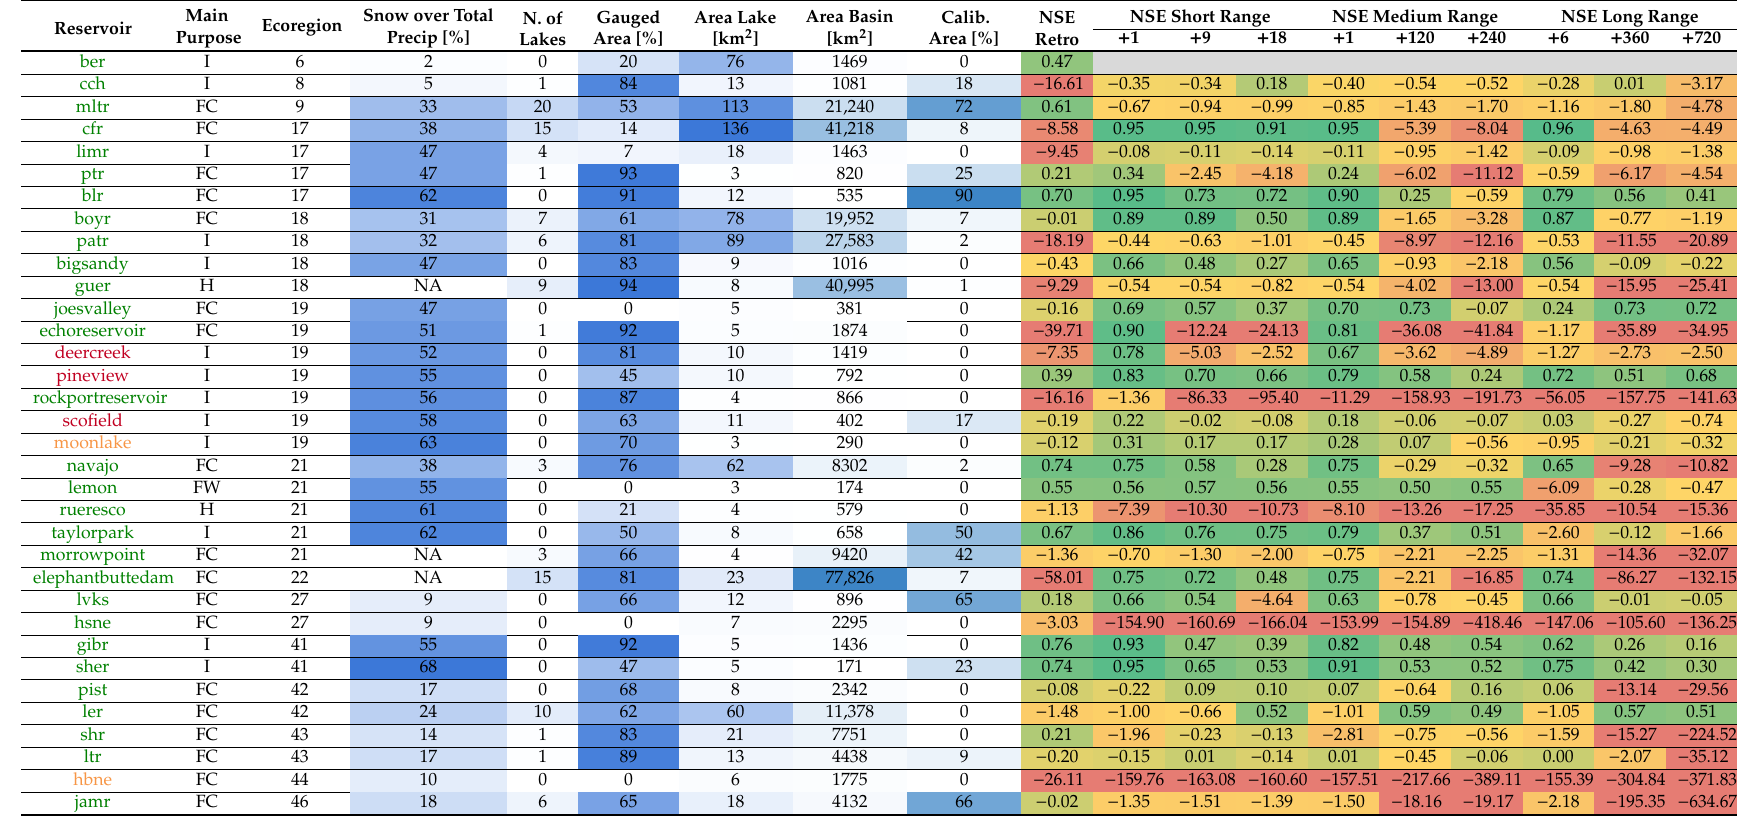
Table 4. Summary of reservoir characteristics and NSE skill scores for retrospective and forecasts (following page). The color densities indicate higher values for the characteristics (e.g., larger lake surface area) while the red to green densities for the NSE scores indicate the relative performance (red is worse and green is better). Ber does not show scores for the forecast since it had more than 30% missing data for the forecast period, as explained in Section 2.3.1. NA values for snow % are associated with places in which the nearest USGS was not included in the GAGES2